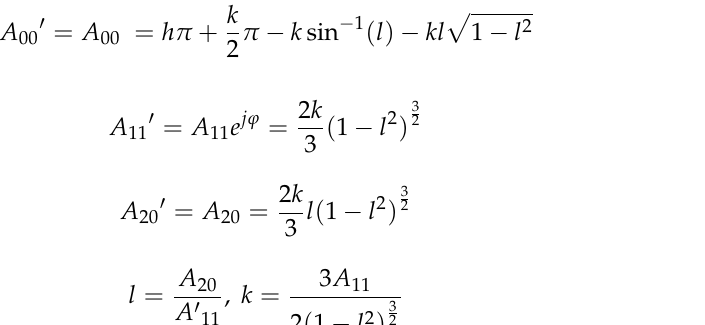
where A 00 and A 11 denote the Zernike moments of each order, A 11 (cid:48) is the complex mo- ment, and A 20 is the result of A 20 (cid:48) after the edge is rotated clockwise by ϕ . Meanwhile, the parameters k and l represent the precision of edge detection and the coarseness of edges,